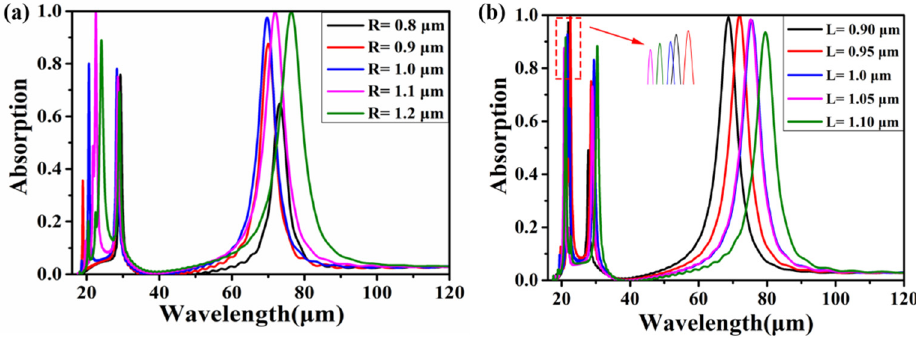
Figure 5. ( a ) The relationship between the radius R of the disc and the light absorption rate. ( b ) The relationship between the side length L of the square and the light absorption. relationship between the side length L of the square and the light